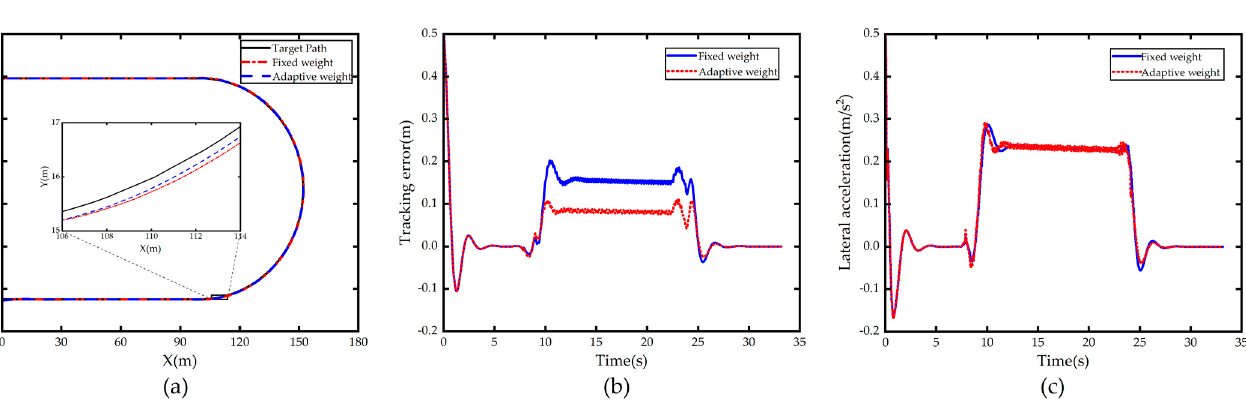
Figure 8. Comparison of 40km/h simulation results in Scenario 1. ( a ) Path; ( b ) Tracking error; ( c ) Lateral acceleration.